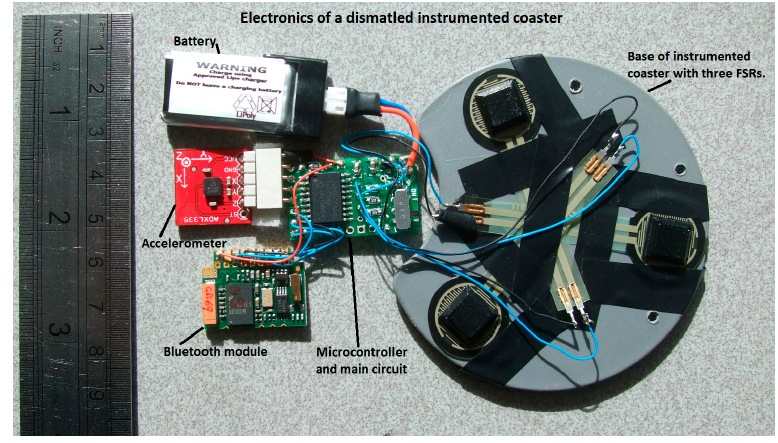
Figure 3. CogWatch coaster.